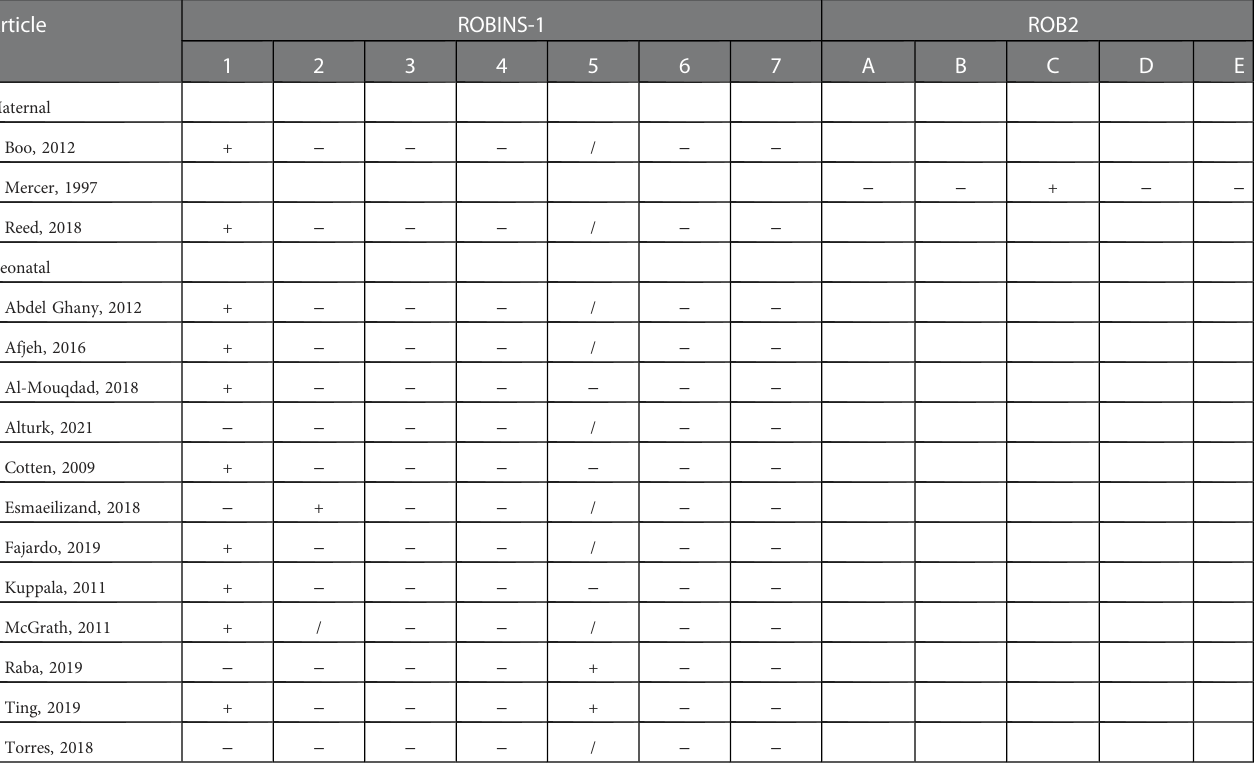
TABLE 6 Risk of bias score for all included studies.